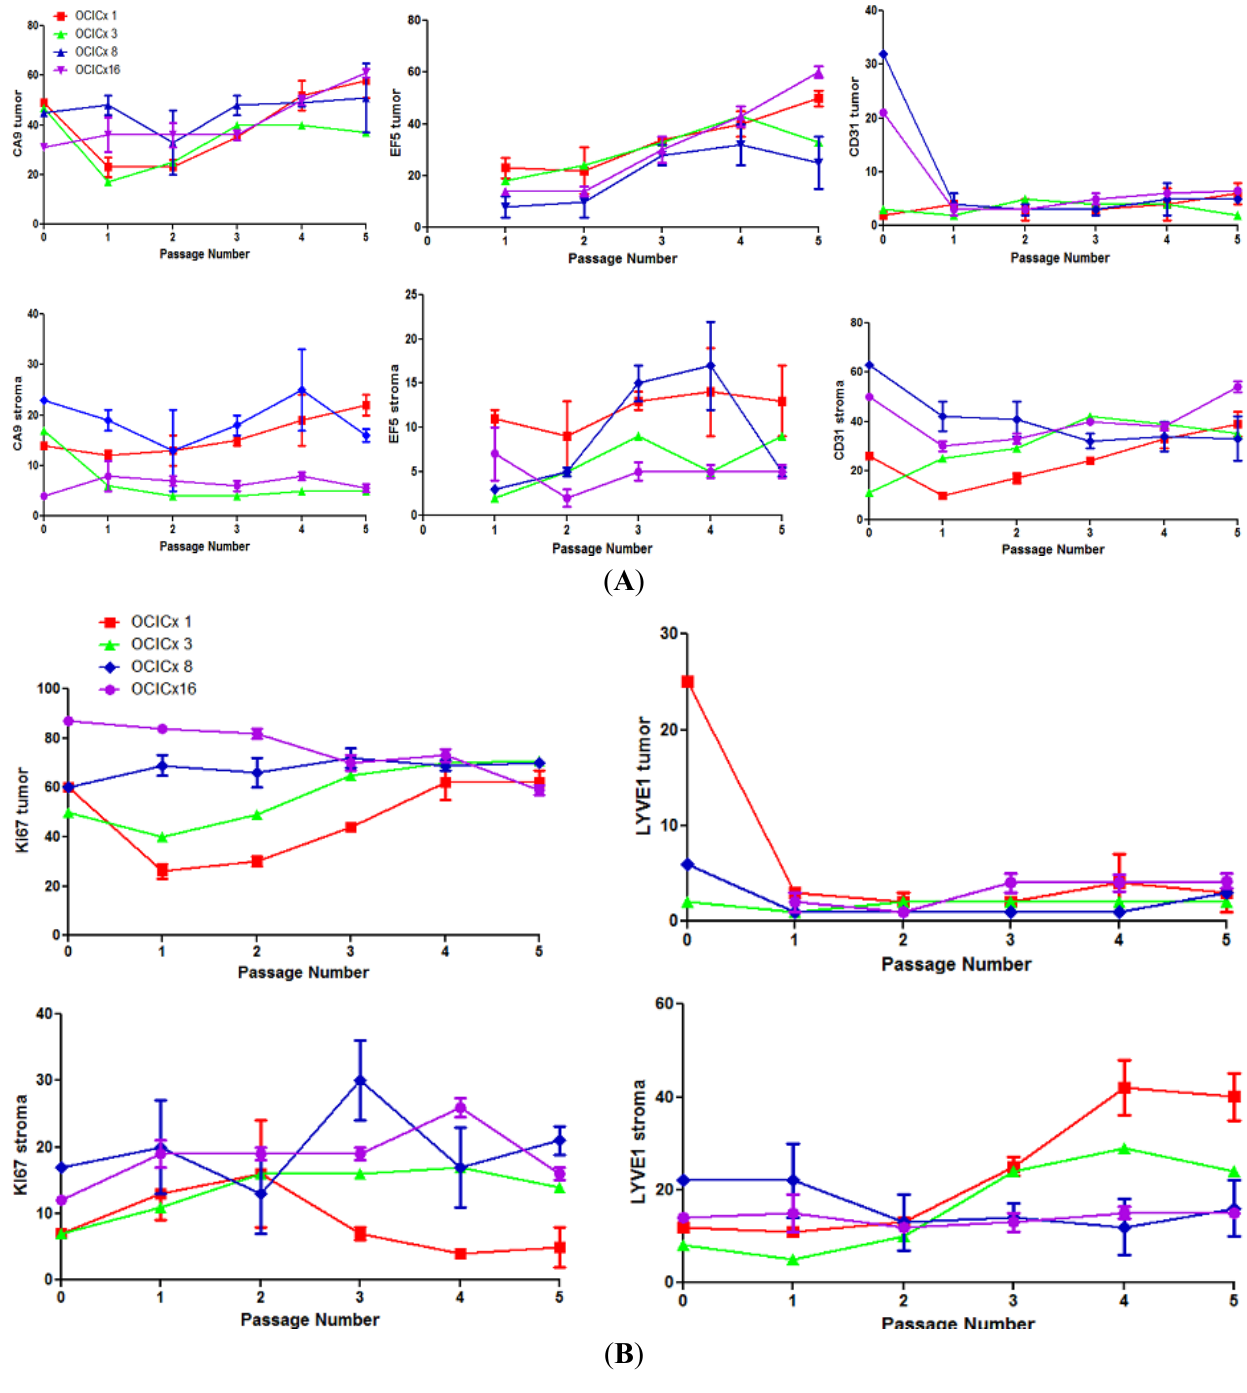
Figure 7. Quantitation of the staining for the various markers in the tumor and stromal components separately in the 4 models (OCICx 1, 3, 8, 16) over passage number. The percent pixel positivity is shown for each marker ( A ) CA-9, EF5, CD31; ( B ) Ki67 and LYVE1. Values plotted are mean ± SD. Passage 0 indicates biopsy